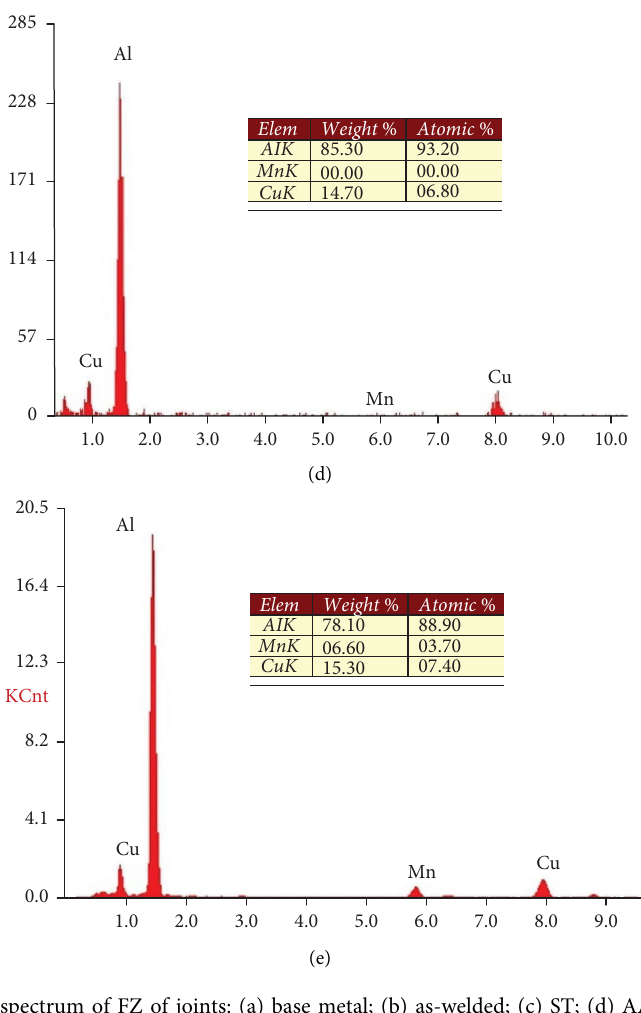
Figure 9: EDS spectrum of FZ of joints: (a) base metal; (b) as-welded; (c) ST; (d) AA; and (e)